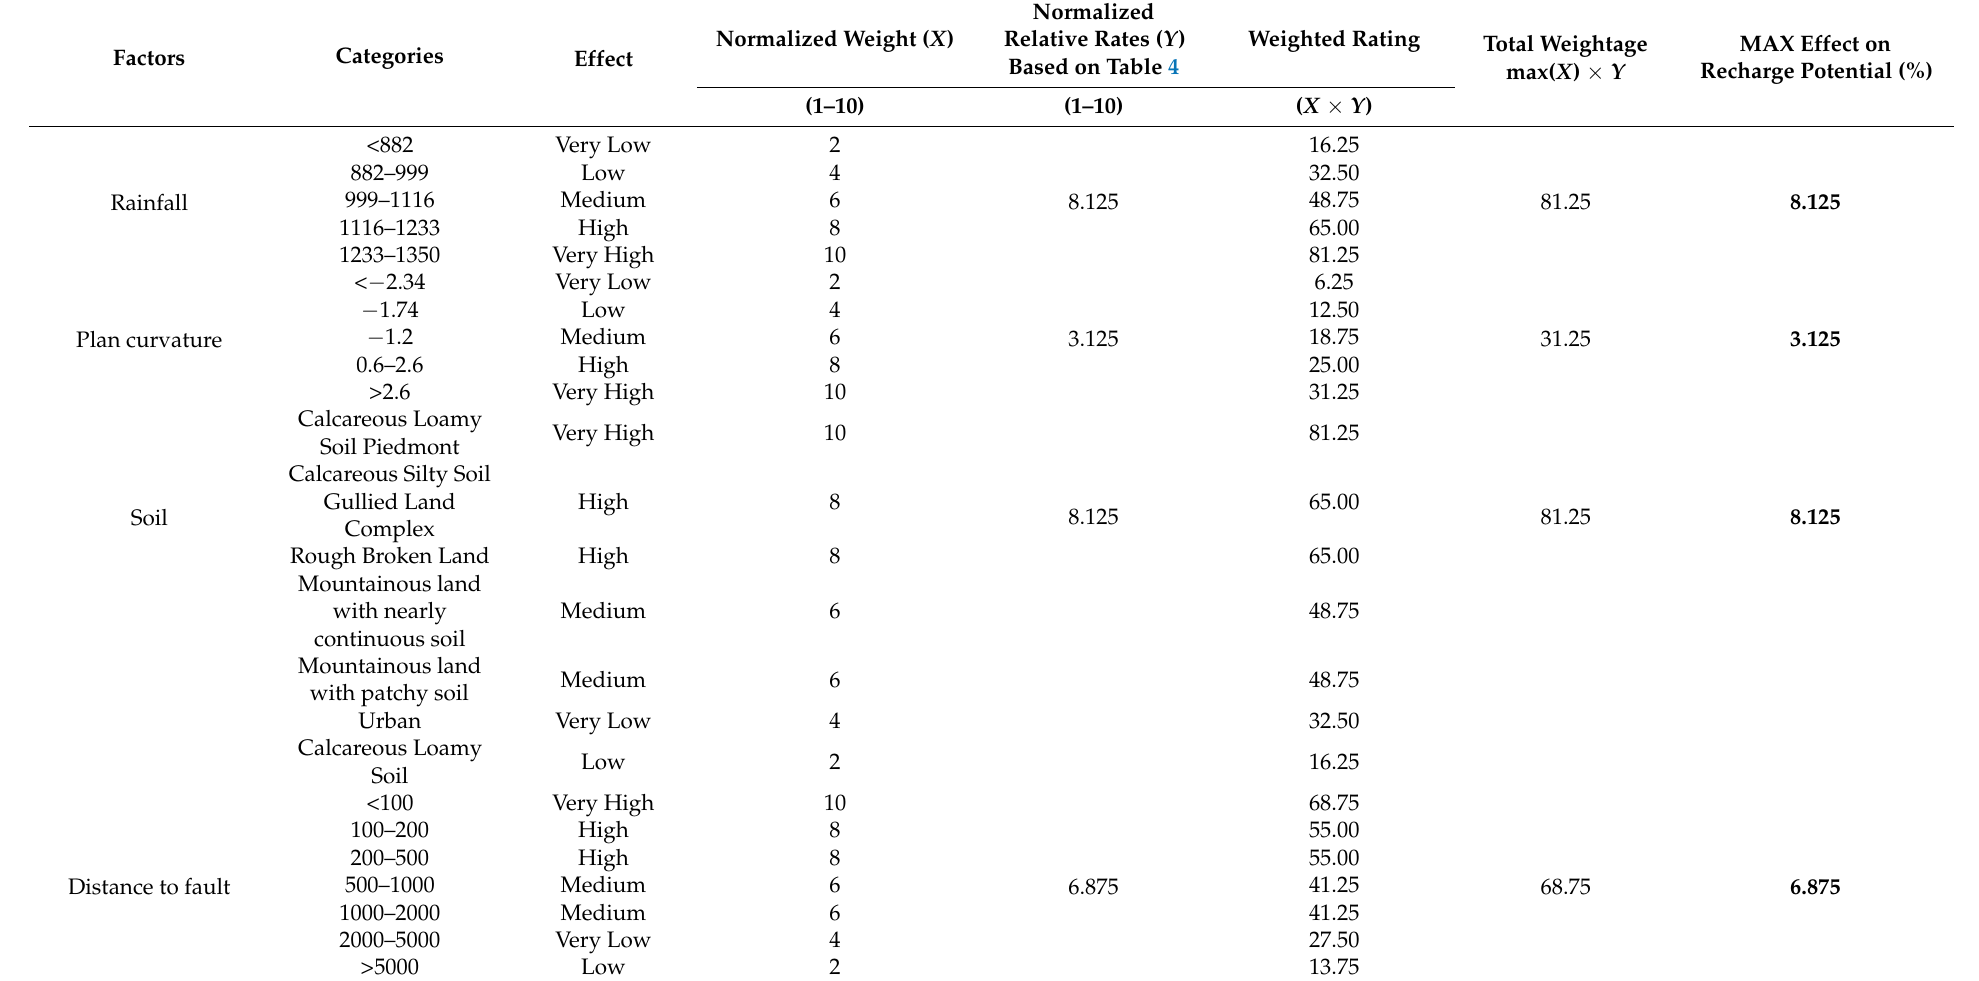
Table 5. Weight evaluations of factors influencing potential recharge